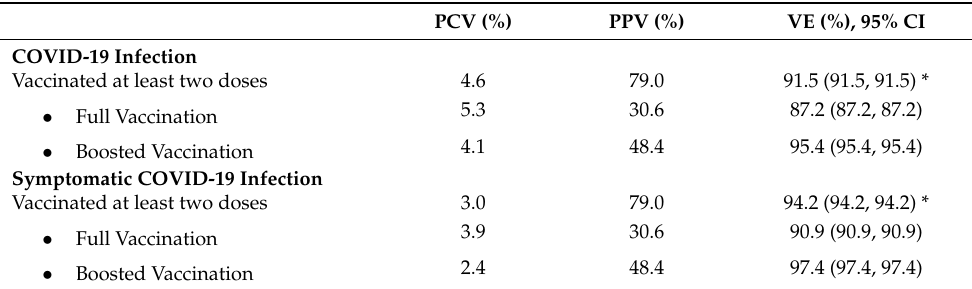
Table 2. Proportion of COVID-19 cases within the vaccinated population, the proportion of the population vaccinated against COVID-19 and vaccine effectiveness estimates according to vaccination status and presence of symptoms during infection.